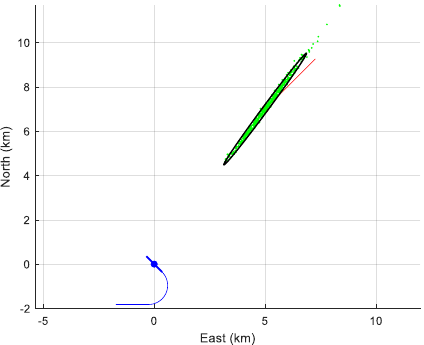
Figure 6. The cloud of the 500 initial positions estimates and the 90%−confidence ellipse. The performance of the estimator (bias and standard deviation of each component) is presented in Table